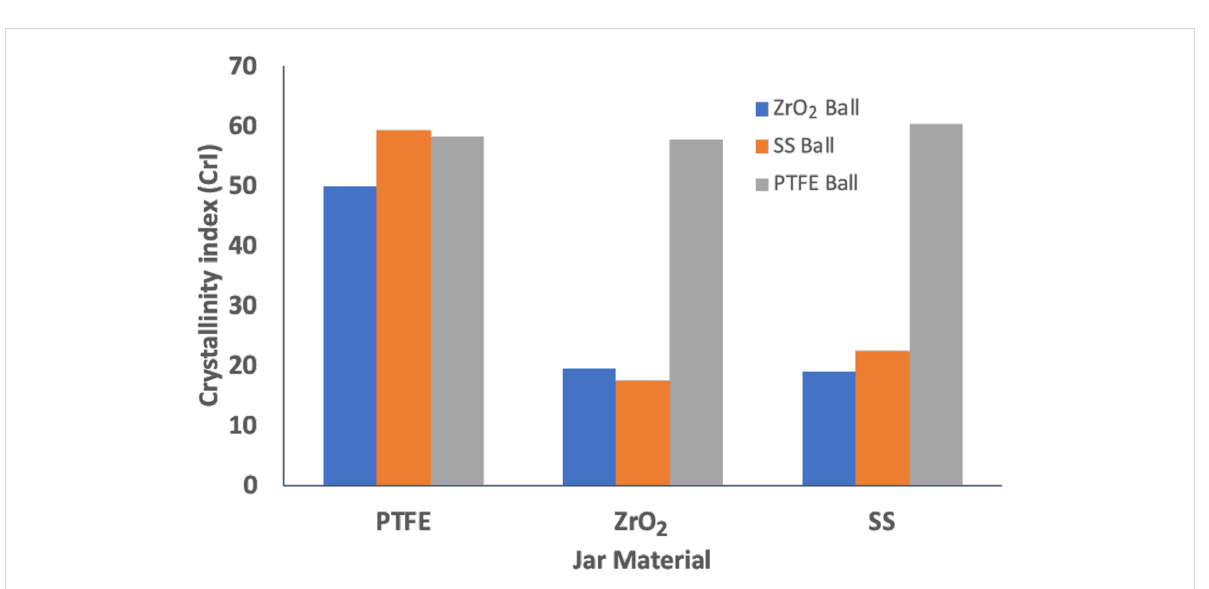
Figure 4: Crystallinity index (%) of chitin milled with 9.5 mm balls of PTFE, ZrO 2 and SS each used in jars of PTFE, ZrO 2 or SS. Experimental condi- tions: 200 mg of chitin, milling time: 30 min, milling frequency 29.5